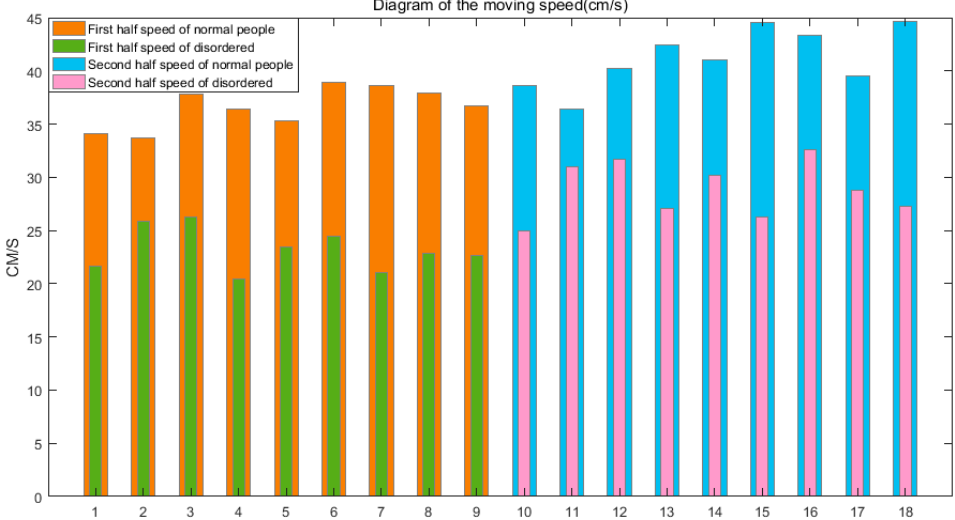
Figure 7. Comparison of the moving speed for different groups (cm/s).